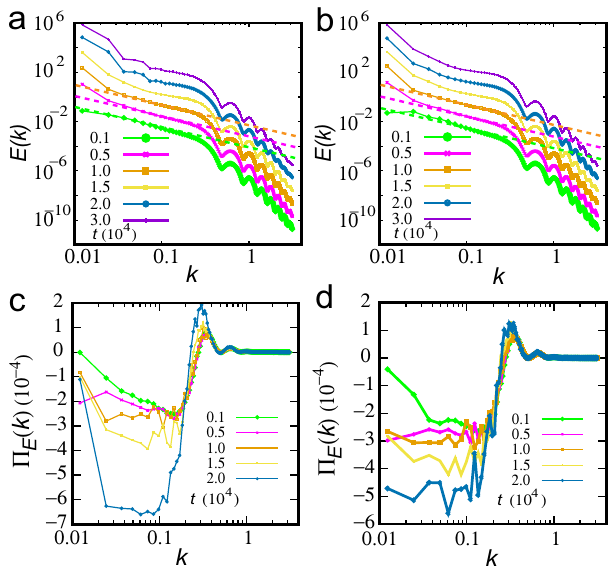
Fig. 7 The time evolution of the energy spectrum E ( k ) and the energy fl ux Π E ( k ). a , b The time evolution of the k -dependence of the kinetic energy E ( k ) for off-symmetric ( a ) and symmetric ( b ) cases at Re = 10.8. Different colours of the curves and symbols correspond to different times. In the early stage before phase separation, we can see approximately the − 5/3 scaling law (see the dashed line) below the wavenumber corresponding to the particle size, which is the characteristic size of our system ’ s energy input. The scaling law suggests the inverse cascade characteristic of two- dimensional (2D) turbulence (see below). After phase separation is induced, we cannot see such a scaling due to the formation of large-scale fl ow structures 87 : The low-wavenumber upturn re fl ects the macroscopic fl ow organisation accompanied by phase separation. c , d The time evolution of the k -dependence of the energy fl ux Π E ( k ) for asymmetric ( c ) and symmetric ( d ) cases at Re = 10.8. We can clearly see the negative energy fl ux, the evidence of the inverse energy cascade for both asymmetric and symmetric cases.